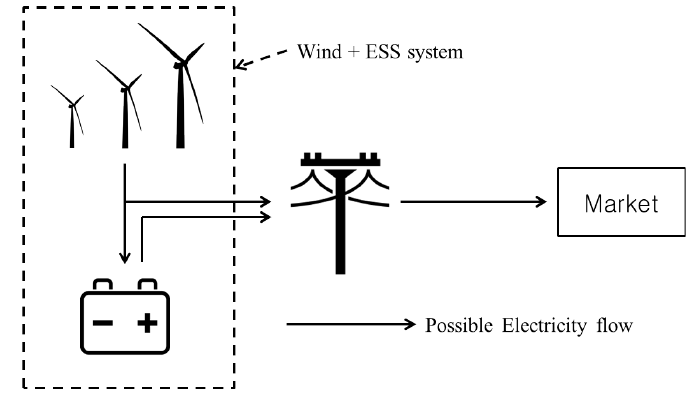
Figure 1. System